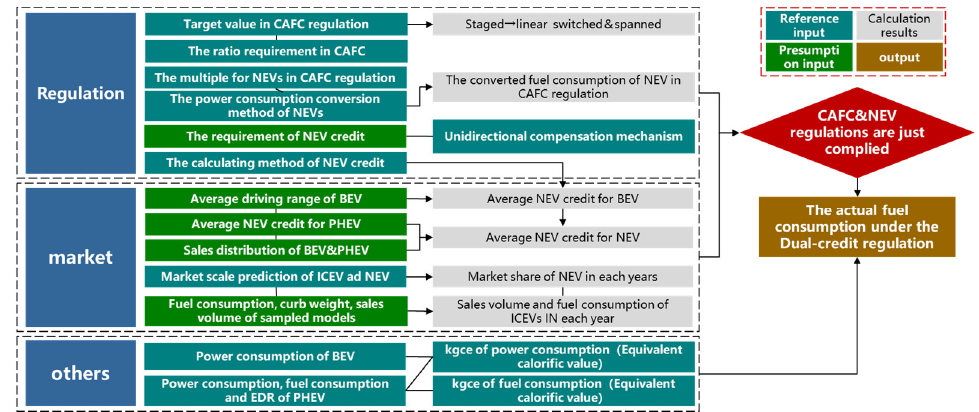
Figure 2. The framework of the calculation method. ICEV: Internal combustion engine vehicle; EDR: Electric Distance Ratio; CAFC: Corporate Average Fuel